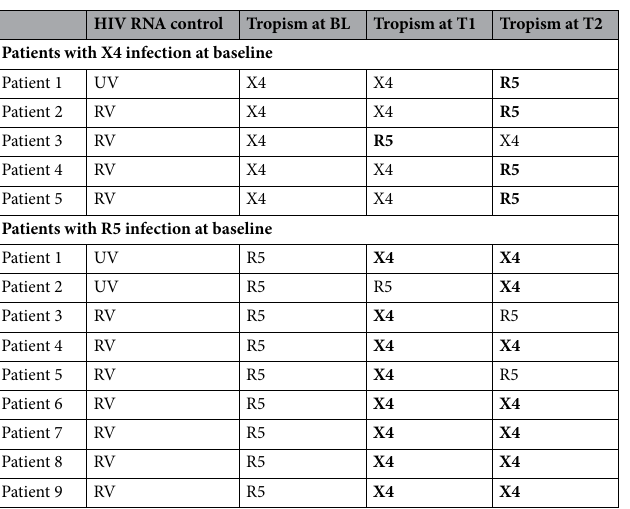
Table 4. Description of tropism changes at T1 and T2: patients are classified according to X4 tropic or R5 tropic virus infection at baseline. Bold characters correspond to tropism modification respect to BL.